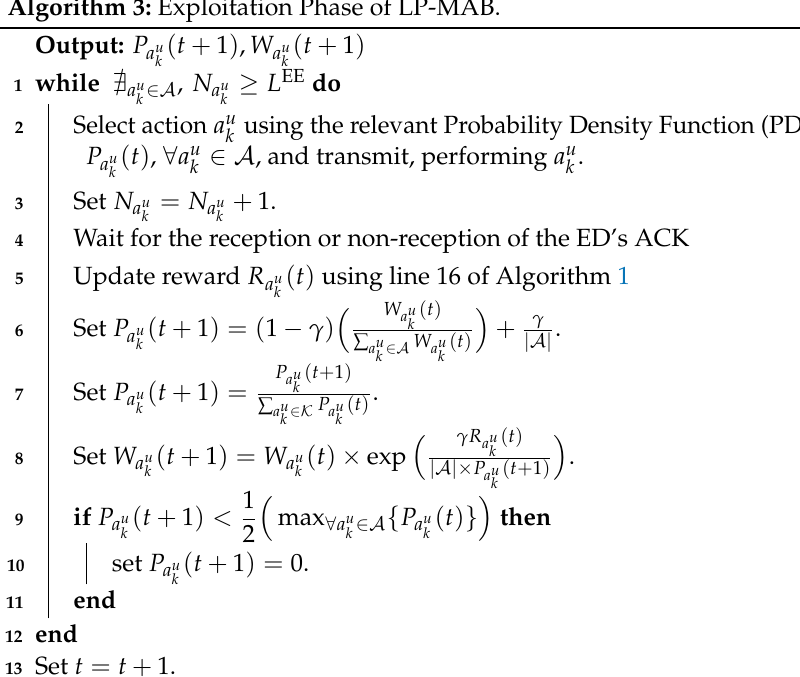
Algorithm 3: Exploitation Phase of